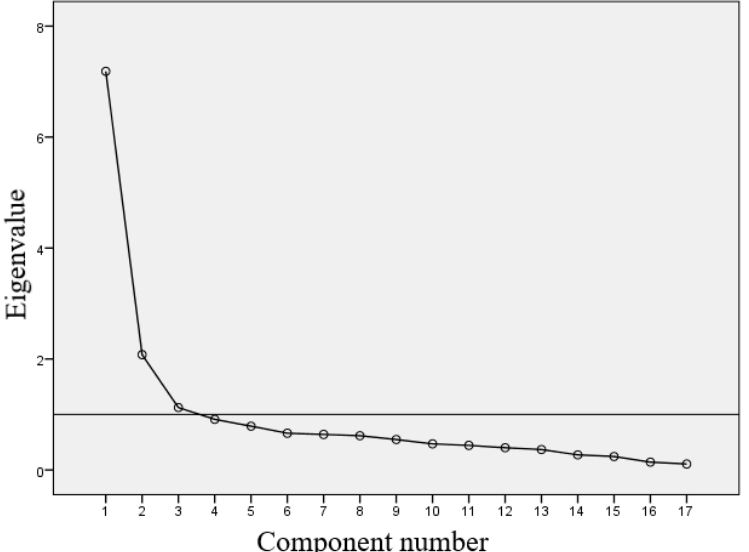
Figure 1. Scree plot. Source: own calculations.